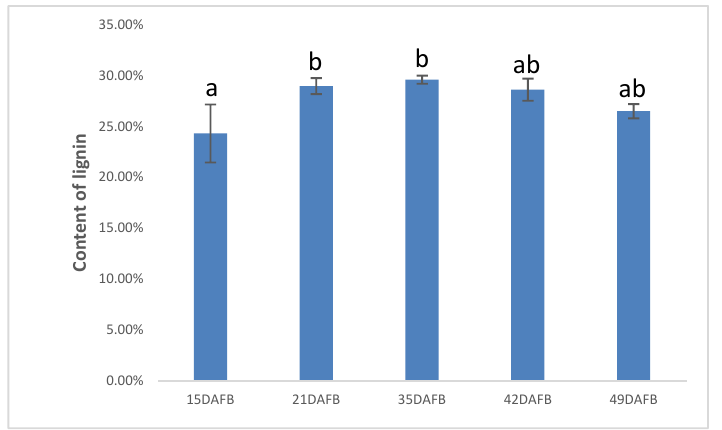
Figure 6. Lignin content in the pulp powder. Different small letters indicate significant difference at 0.05 level.